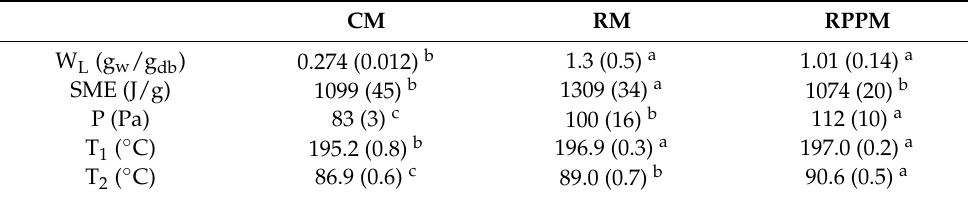
Table 1. Mean values (and standard deviations) of water loss (W L ), specific mechanical energy (SME), melt pressure (P), and barrel temperatures (T 1 , T 2 ) of the studied samples.